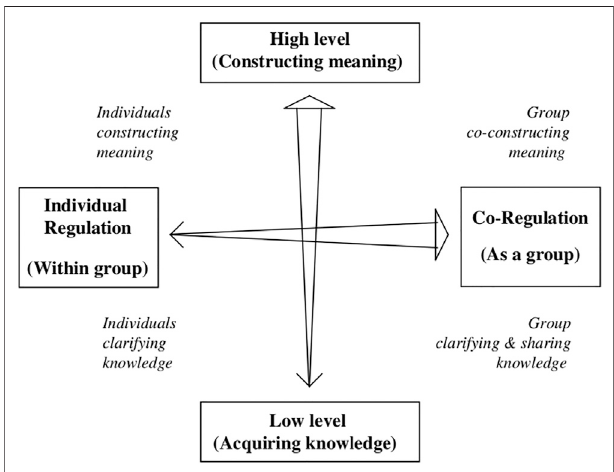
FIGURE 2 | Volet et al. ’ s framework for socially-regulated learning , p.